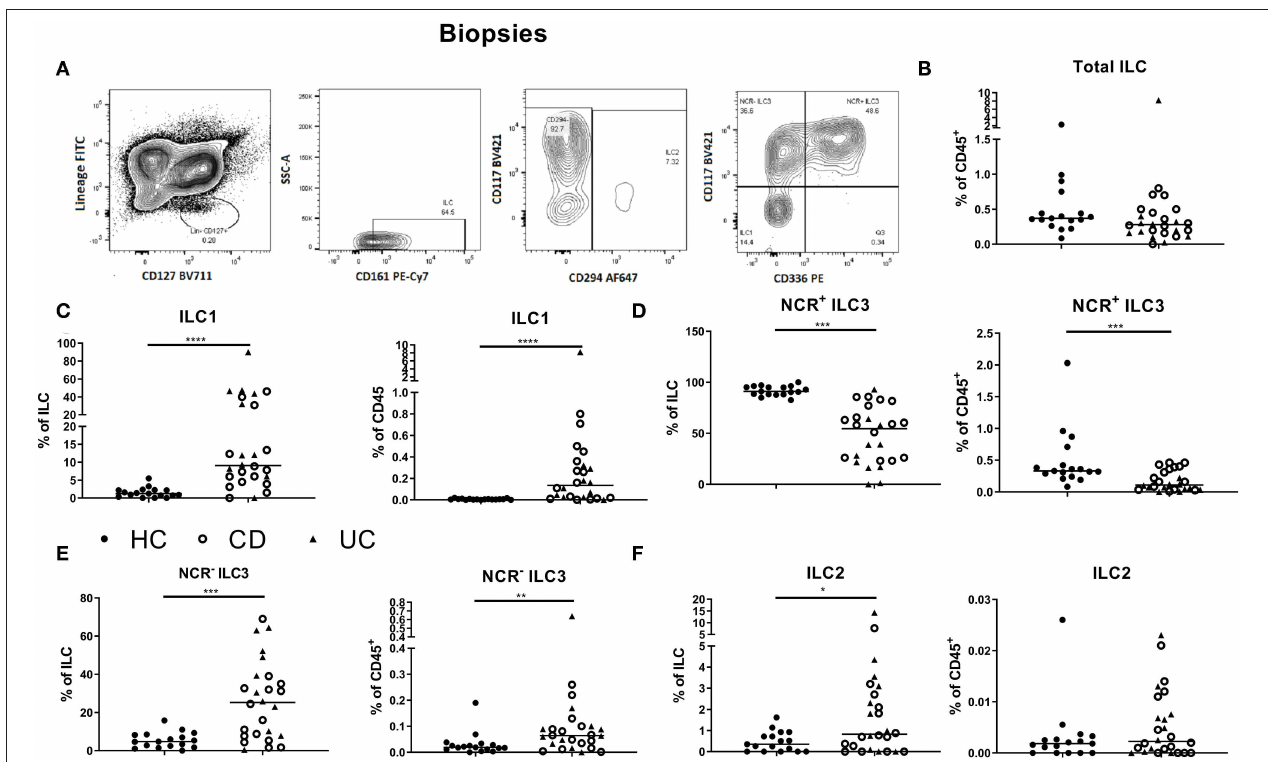
FIGURE 1 | Innate lymphoid cell distribution in colonic biopsies of active IBD patients. Gating strategy for identification of innate lymphoid cells (ILCs) in intestinal biopsies. Gating was based on FMO and tonsil staining. Representative data in (A) are shown as contour plots (5%) with outliers (A) . Innate lymphoid cells